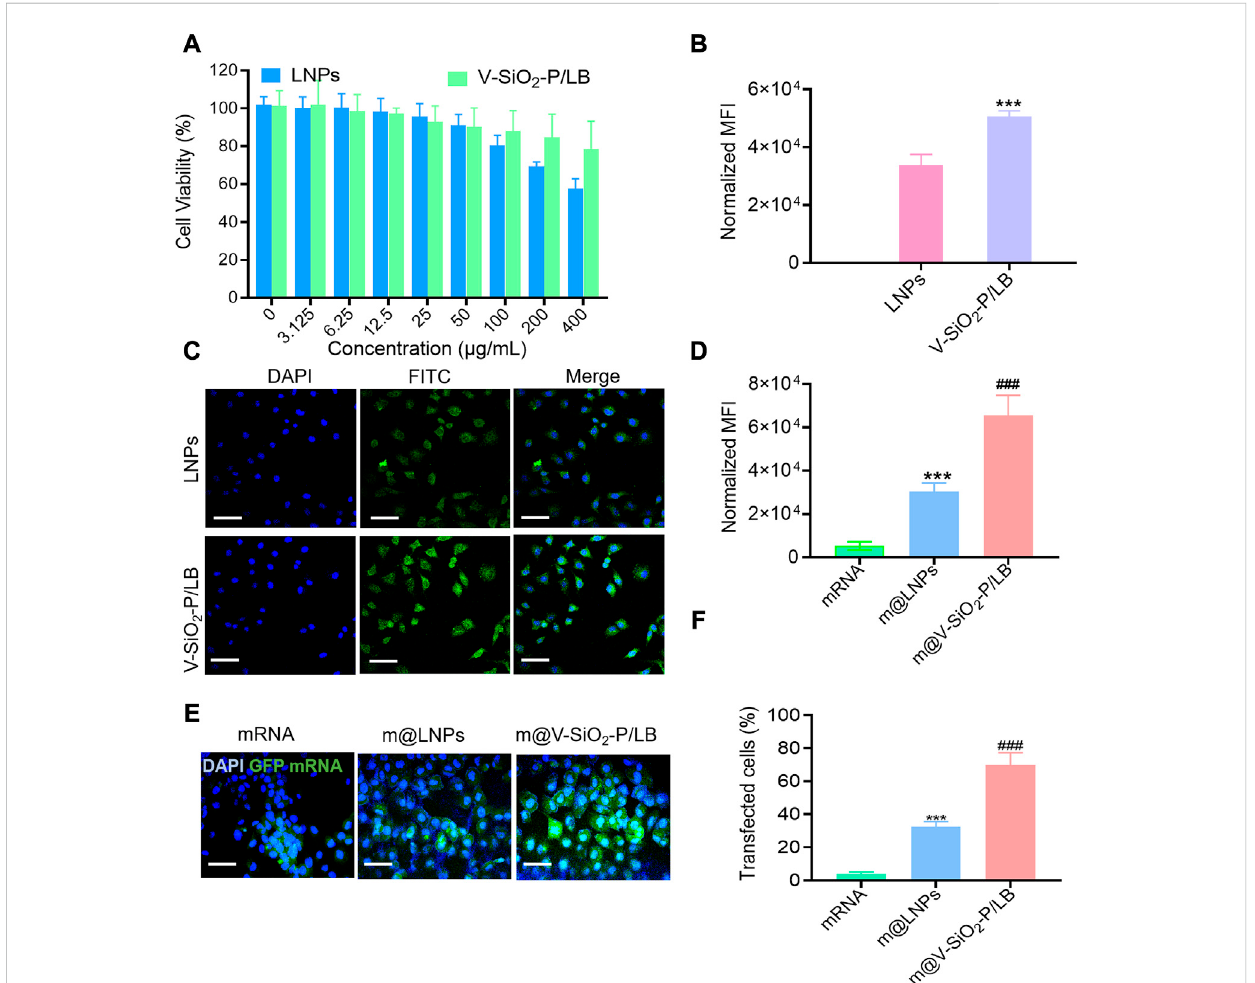
FIGURE 3 In vitro cellular internalization and GFP mRNA transfection. (A) Viability of L02 cells treated with LNPs or V-SiO concentrations ranging from 0 to 800 μ g/mL for 24 h. (B) Quanti fi cation of FITC fl uorescence in L02 cells treated with FITC-labelled NP or V-SiO 2 -P/LB nanoparticles (100 ng per well, 3 h, n = 3). *** p < 0.001. (C) Confocal laser scanning microscopy (CLSM) observations of L02 cells after incubation with LNPsandV-SiO 2 -P/LBnanoparticlesfor6 h.Scalebar:50 μ m. (D) Quanti fi cationofgreen fl uorescenceintensity(indicatingGFPexpressionlevel)in L02cellstreatedwithfreeGFPmRNA,m@LNPs,m@V-SiO 2 -P/LBnanoparticles(100 ngperwell,3h, n =3).*** p < 0.001vs.mRNA,### p < 0.001vs.m@ LNPs. (E) CLSM confocal microscopy images of GFP expression in L02 cells treated with free GFP mRNA, m@LNPs, m@V-SiO 2 -P/LB. (F) The effect